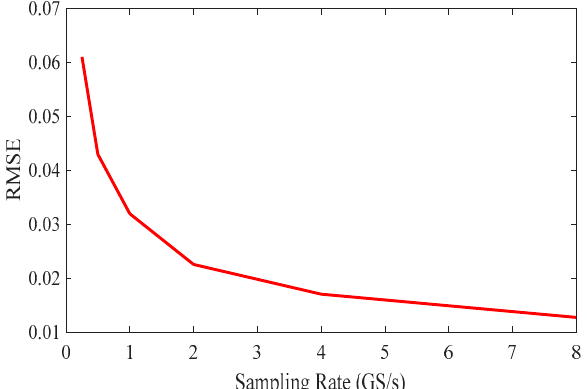
Figure 7. Results of denoising, the factor RMSE, in the various sampling rates of RF signals.